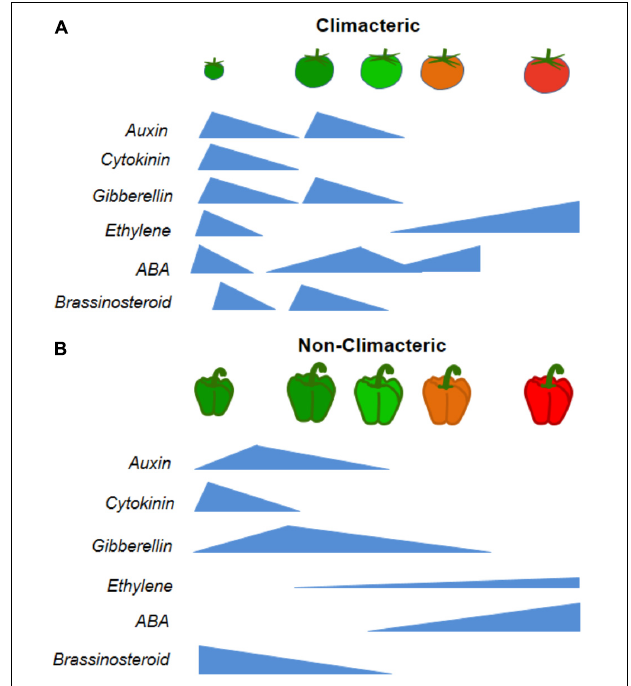
FIGURE 2 | Hormonal pattern changes of two significant examples of climacteric (Solanum lycopersicum) or non-climacteric ( Capsicum spp.) during fruit development and ripening. (A) Differential hormones concentrations in tomato fruit during development: increases in auxin, cytokinin, gibberellin, and brassinosteroids at fruit set, followed by increases in auxin, cytokinin and gibberellin at fruit growth until maturation, which have their levels drastically reduced, with increases in ethylene and abscisic acid (ABA). (B) Differential hormonal patterns in non-climacteric fruit during development show increases in auxin, cytokinin and gibberellin during fruit set and growth, followed by reductions along the maturation phase, with increases in ABA and brassinosteroids, and few changes in